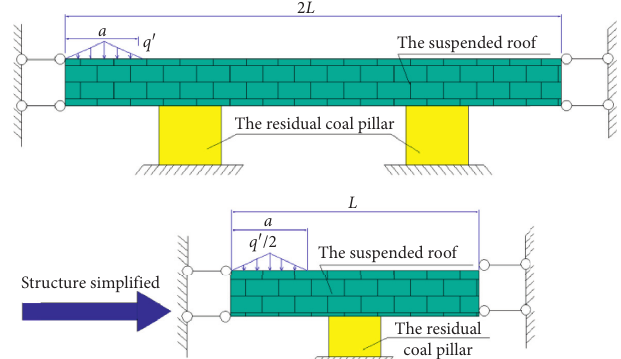
Figure 6: Model simplification bearing only varied triangular